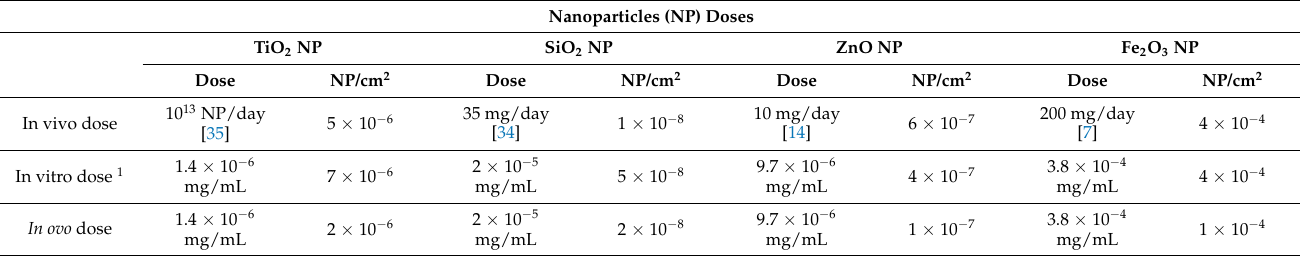
Table 1. Physiologically relevant nanoparticle (NP) doses extrapolated from the real human intake used in vitro studies and the current in ovo study expressed as mg/mL and NP/cm 2